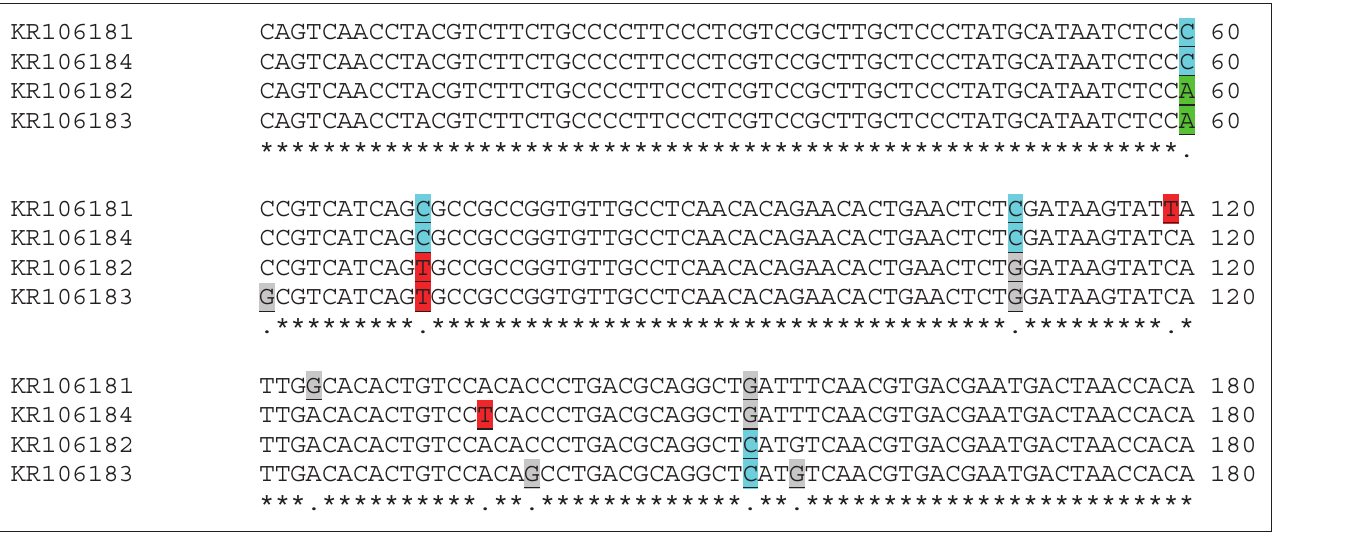
An asterisk represents an exact match between all sequences; a dot (•) represents a mismatch in at least one sequence. FIGURE 3: Partial sequences of the Nc-5 gene from four isolates of Neospora caninum from sheep samples.